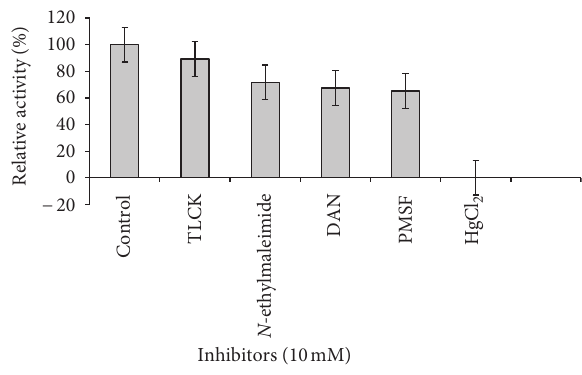
depolymerase by double reciprocal plot.